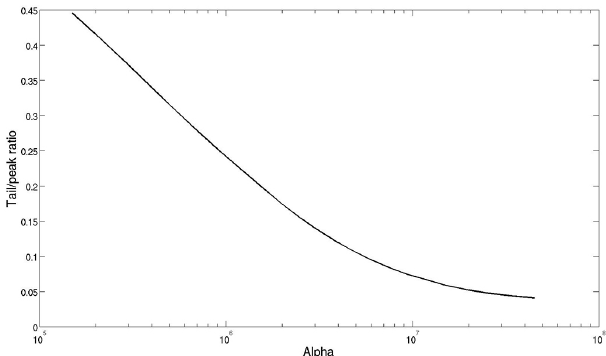
Figure 5. Ratio of tail to peak power, < P_r_l >/ max(P_r) where < P_r_l > is the average power of points within 10 ns following the point of peak power. These results are taken directly from the phys- ical model in Sect. 3. This is used to provide an initial guess in the fitting of waveforms over leads. The x axis is a logarithmic scale to better show the variation over the large dynamic range of α